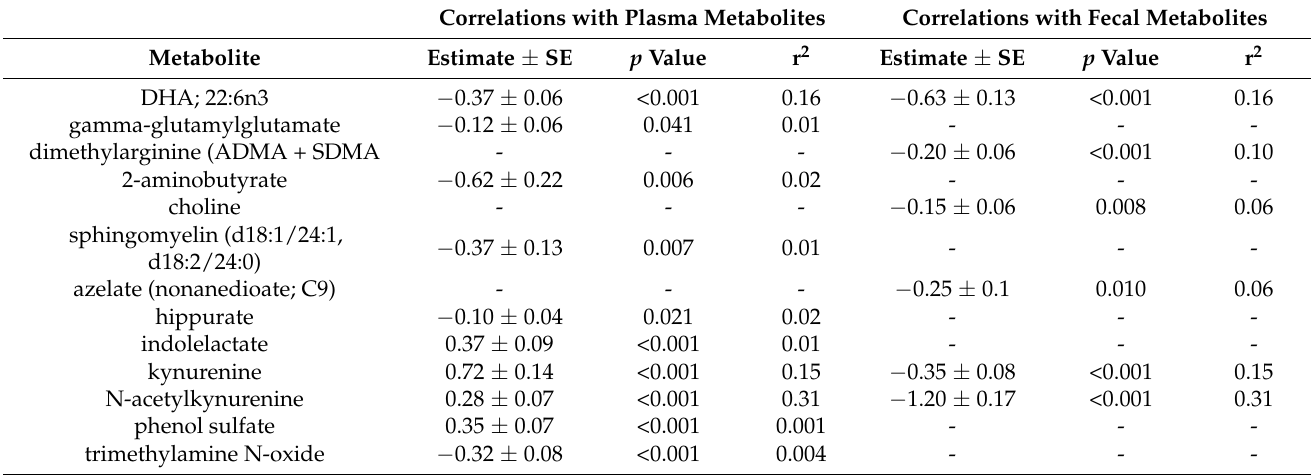
Table 7. Significant correlations between levels of plasma 4-ethylphenyl sulfate and levels of plasma and fecal metabolites of